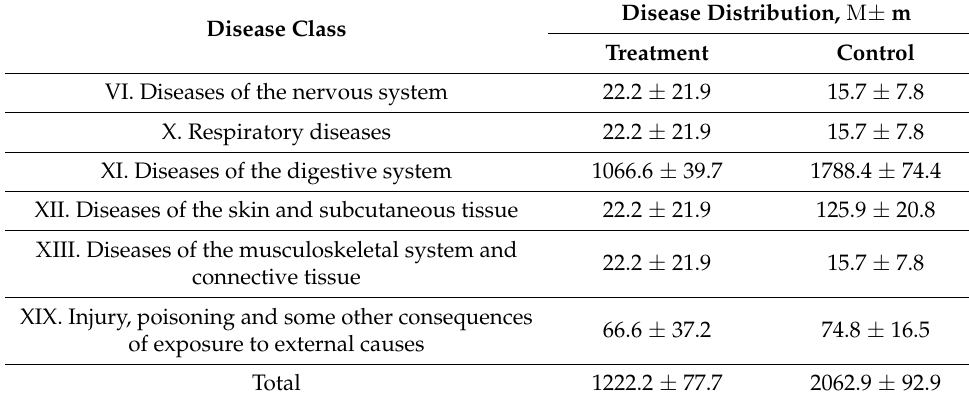
Table 11. The distribution of diseases by the most prevalent classes during the observation period, ‰.